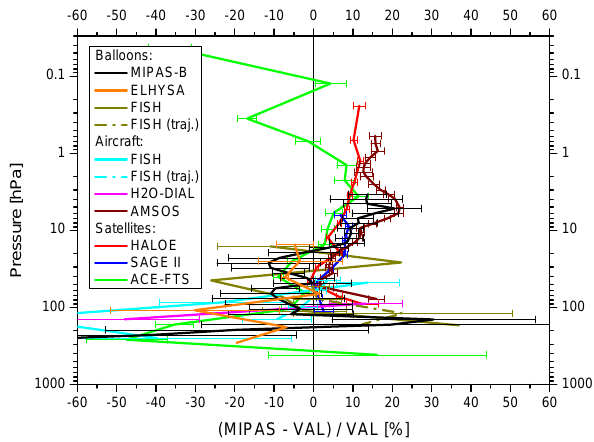
Fig. 21. Summary of mean relative (percentage) differences between H 2 O profiles measured by MIPAS and individual satellite, balloon and aircraft validation instruments (VAL) including the standard error of the mean (plotted as error bars) as shown in previous sections. The intercomparison refers to a coincidence criterion of 300 km and 3 h (except for FISH trajectory matches: 150 km, 0.5 h). A clear positive bias of roughly 10% is visible in the MIPAS data above about 10 hPa pressure altitude. Ground-based and radiosonde comparisons have been omitted for clarity.